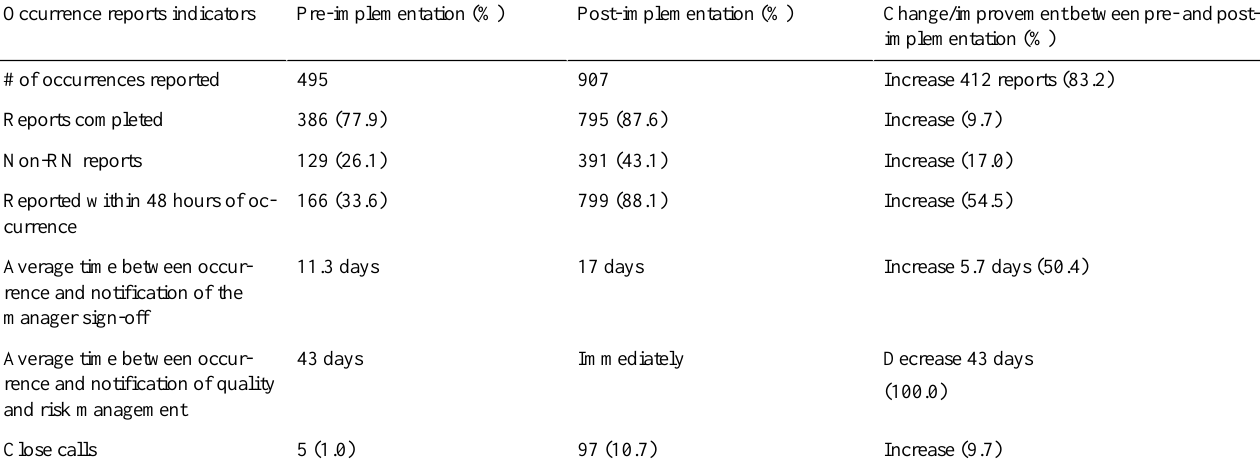
Table 2. Comparison of the 6 months pre-implementation and the 6 months post implementation